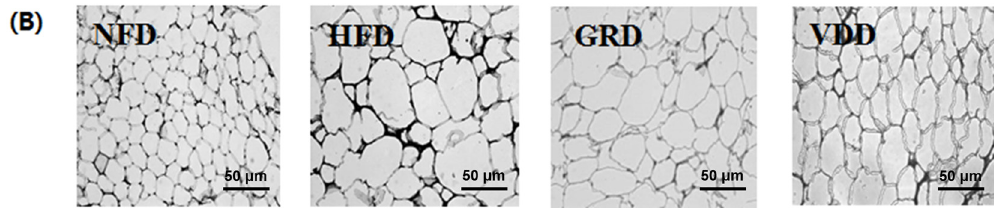
Figure 3. Effects of Valeriana dageletiana Nakai ex F. Maek extract from the above ‐ ground part (VDAE) on epididymal white adipose tissue diameter ( A ) and microphology ( B ) in high ‐ fat ‐ fed mice. Each specimen from the mice groups was fixed with 4% paraformaldehyde and sectioned to 4 μ m, stained with hematoxylin and eosin (H and E), and then viewed using light microscopy magnification, 200×. The image is a representative one. NFD; normal fat diet control, HFD; high fat diet control, GRD; HFD + 1% Garcina cambogia extract, VDD; HFD + 1% Valeriana dageletiana Nakai ex F. Maek extract from above ‐ ground part.